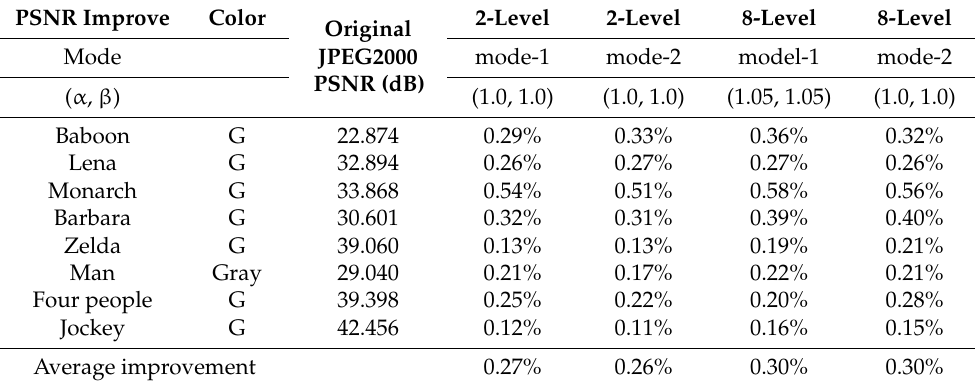
Table 21. Improvement percentage of PSNR with proposed algorithm applying multi-level MQ